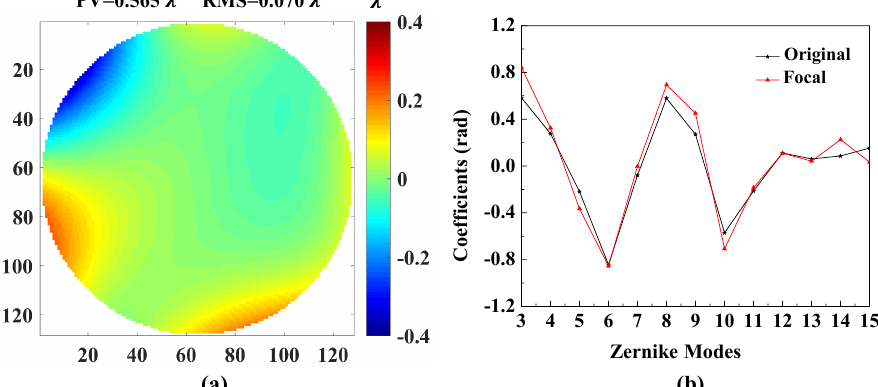
Figure 9. The result of the Focal model of PD-CNN. ( a ) The residual wavefront and ( b ) the comparison of the Figure 8b and the estimated Zernike coefficients. The unit of residual wavefront is λ . The unit of estimated Zernike coefficients is